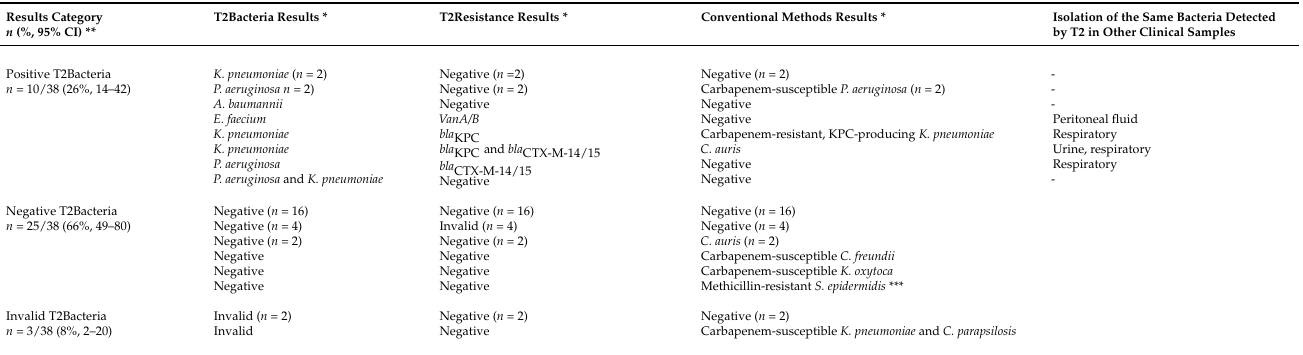
Table 1. Distribution of results of T2Bacteria/T2Resistance panels and conventional blood cul- tures/antimicrobial susceptibility testing.